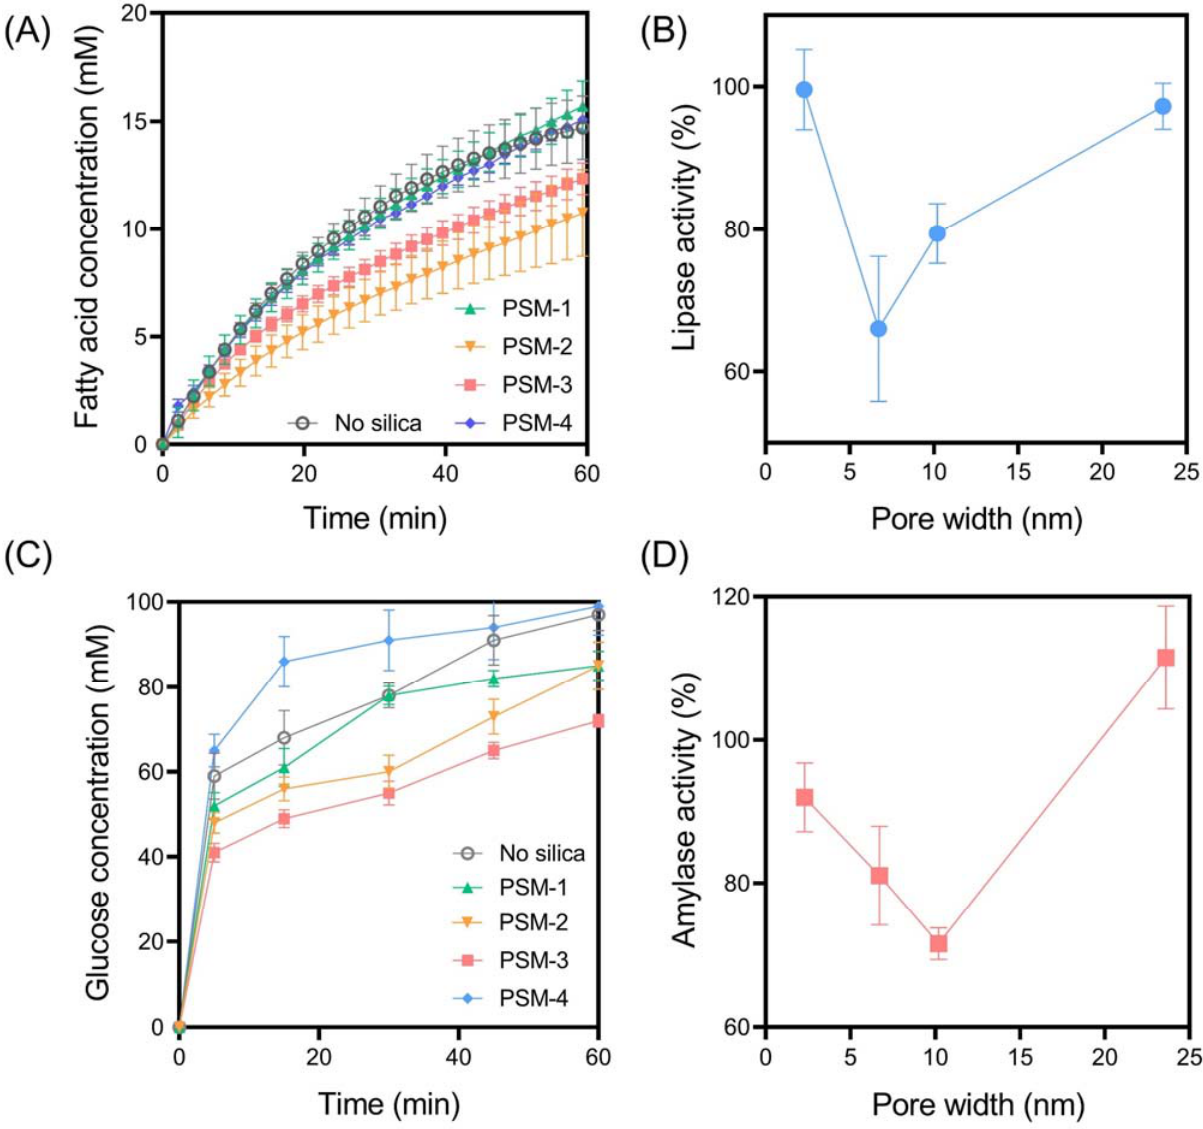
Figure 3. ( A ) In vitro lipid digestion profiles for spherical porous silica microparticles (PSM) with comparable particle sizes but contrasting pore size distributions. ( B ) The impact of PSM pore size on lipase activity. ( C ) In vitro starch digestion profiles for various PSM and ( D ) the corresponding impact of PSM pore size on amylase activity. In vitro digestion studies were performed under simulated fed state conditions, with data representing the digestion occuring during the intestinal phase (pH 6.0). Data represent mean ± S.D. ( n = 3).